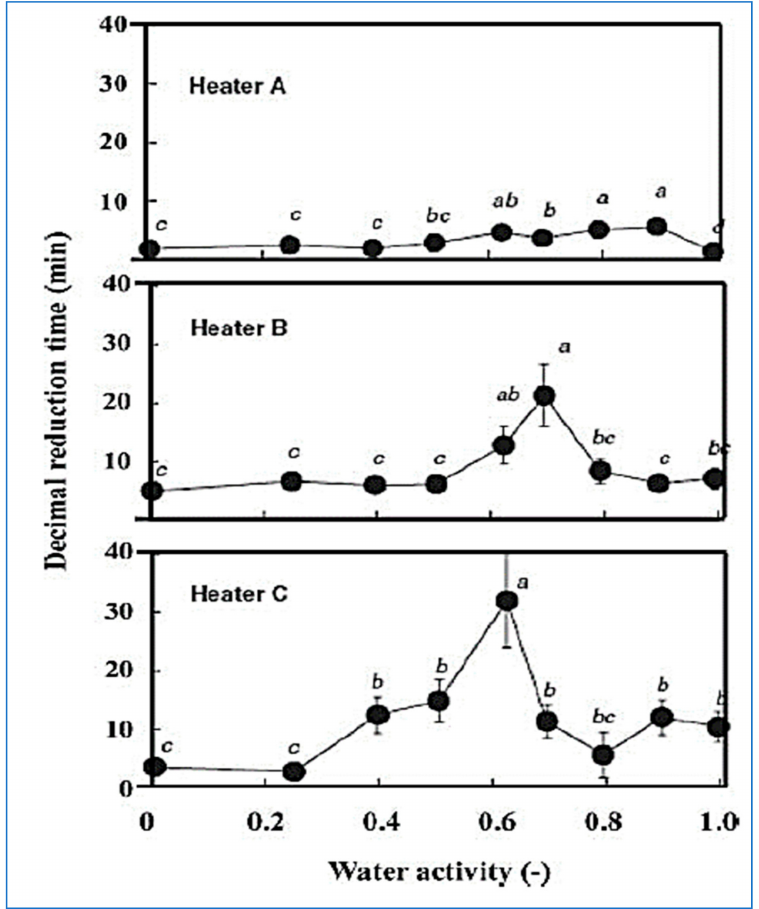
Figure 8. Relationship between water activity and decimal reduction times for B. subtilis spores using infrared treatment